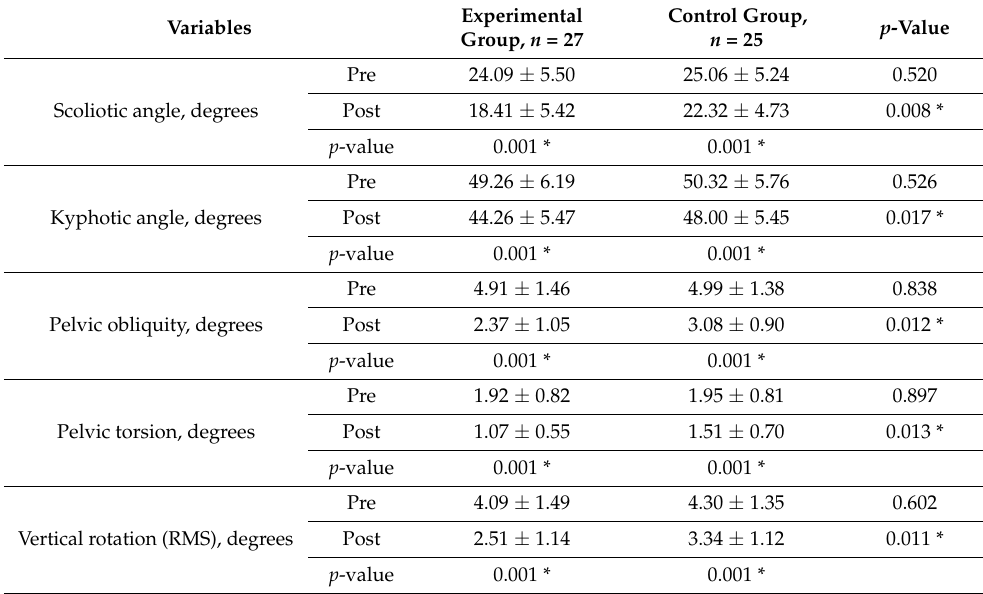
Table 2. Descriptive statistics of the formetric measurements before and after intervention.